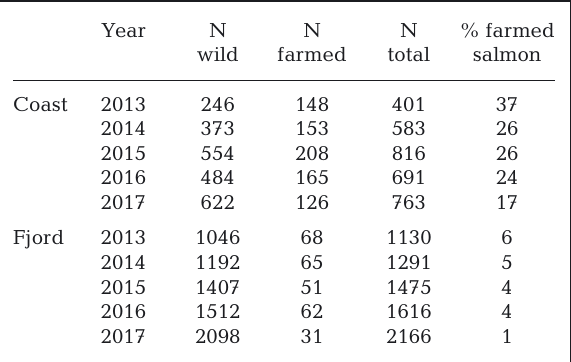
the fjord (GLMM: intercept (coast) estimate (±SE) = −1.09 ± 0.17, contrast fjord = −2.18 ± 0.07, z = −29.36, p < 0.0001). Mean (±SE) proportion of es - caped farmed salmon on the coast was 26 ± 3%, and the variation among years was 17−37%. In the fjord, the mean proportion was 4 ± 0.8%, and the variation among years was 1−6% (Table 1, Fig. 2).